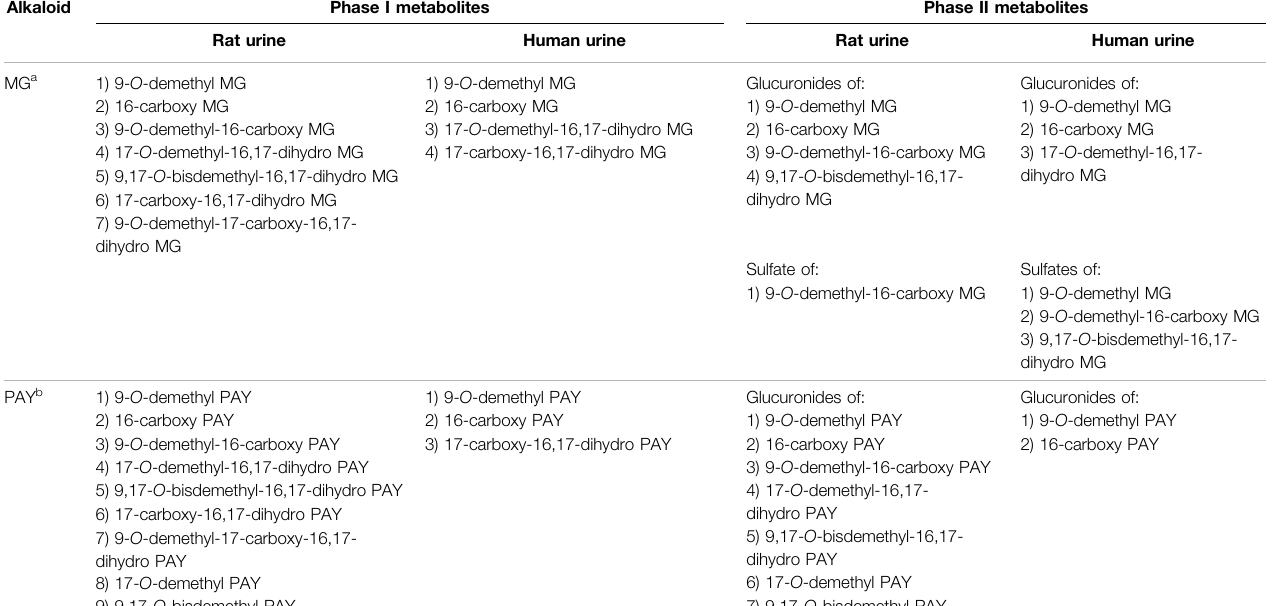
TABLE 1 | Phase I and II metabolites of kratom alkaloids in rat and human urine